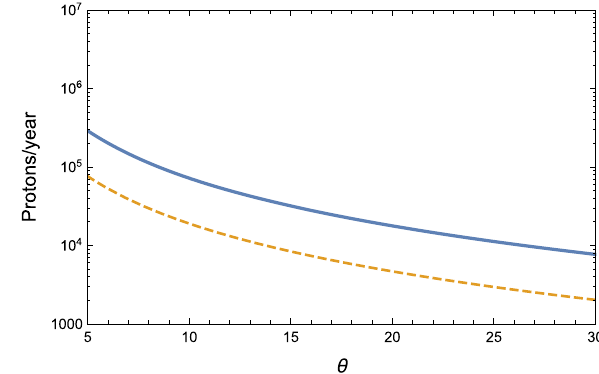
Fig. 4 We compare the results obtained previously for the number of protons scattered with Dirac coupling (solid) with those of β -coupling (dashed) for 500 GeV monopole mass. We have taken for this compar- ison the largest value of d = 240 fm